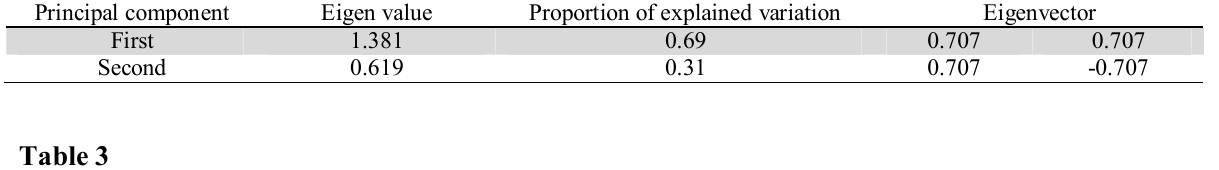
Results of PCA on SNR values of the responses (case study 1) Principal component